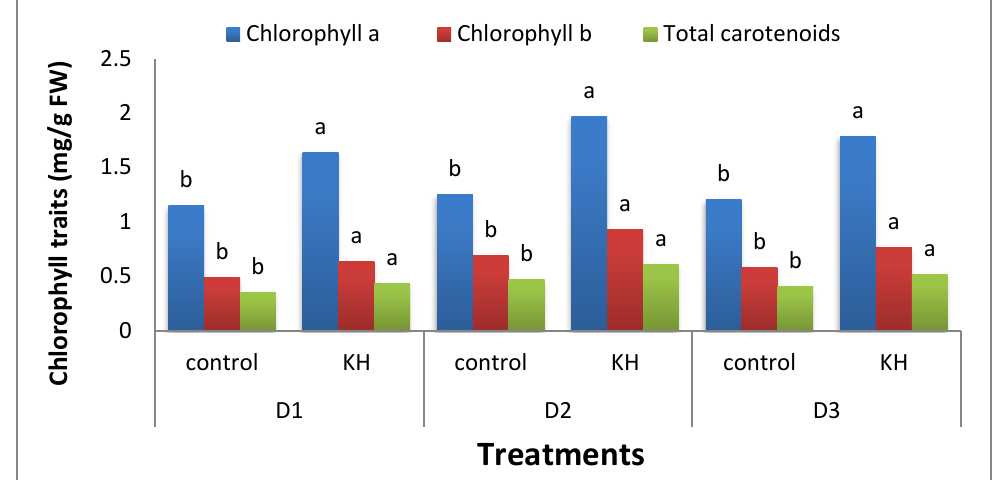
Figure 2. Effect of potassium humate (KH) application and planting density treatment on leaf pigments (mg/g FW) of Vicia faba L. plants. For each parameter, treatments followed by the same letter are not significantly different at p ≤ 0.05.